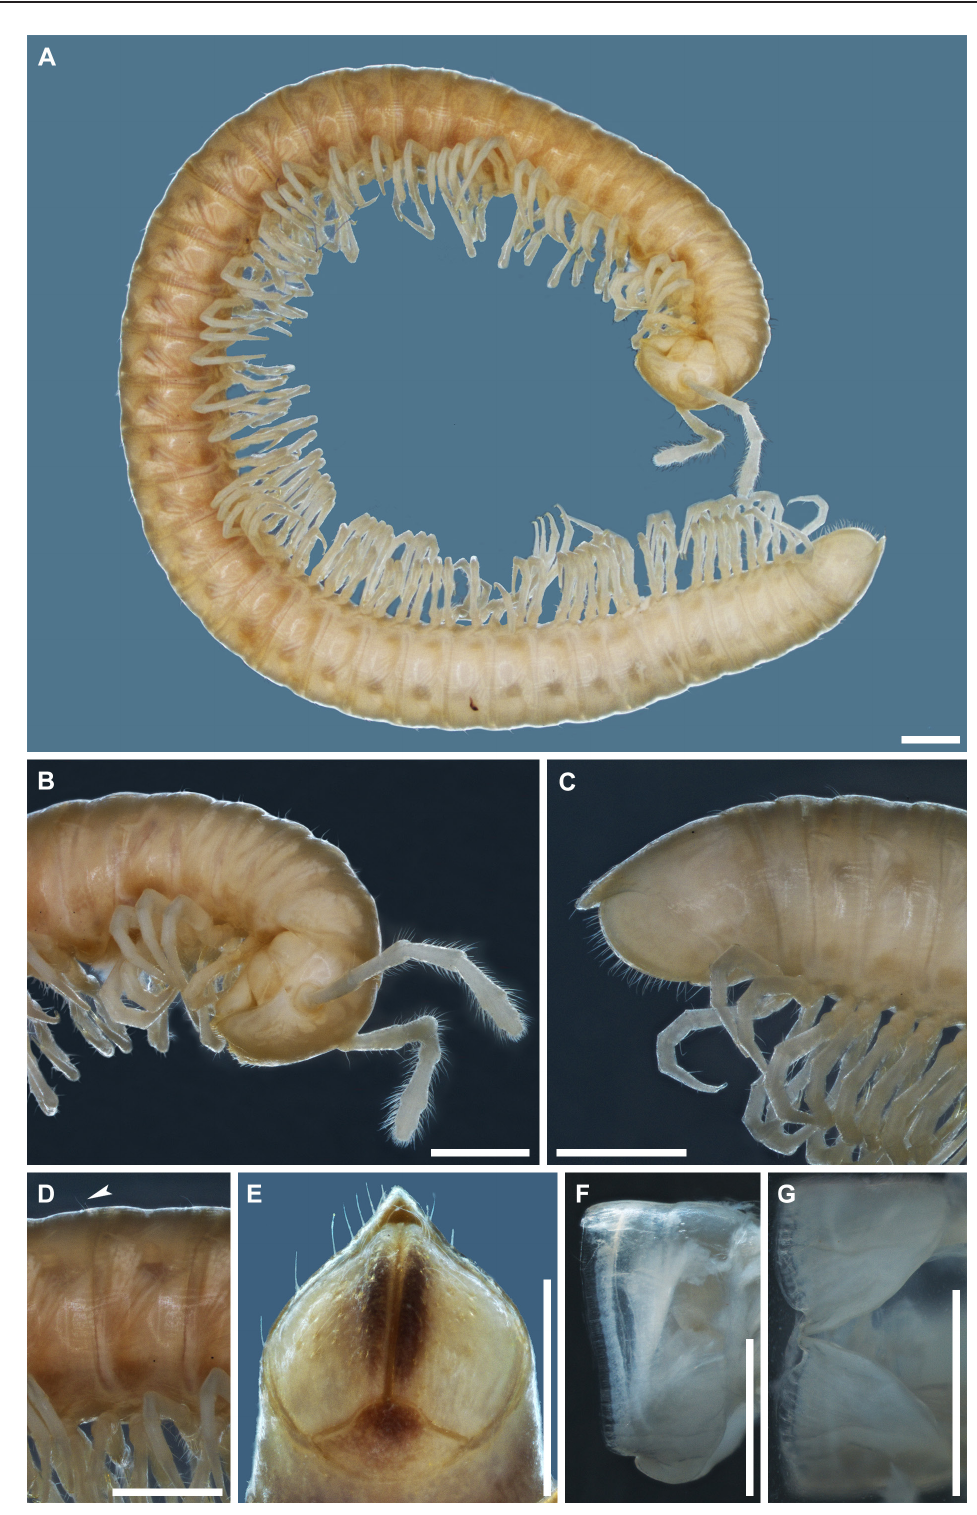
Fig. 42. Leucogeorgia profunda sp. nov. (A–D: holotype ♂ from Krubera Cave (ZMUM); E: non-type ♀ from Veryovkina Cave (IZB); F–G: paratype ♂ from Krubera Cave (ZMUM)). A . Habitus, lateral view. B . Anterior part of body, lateral view. C . Posterior part of body, lateral view. D . Midbody segments, lateral view. E . Telson, posterior view. F . Body ring 7, lateral view. G . Body ring 7, ventral view. Arrow indicates metazonal setae. Scale bars: 1